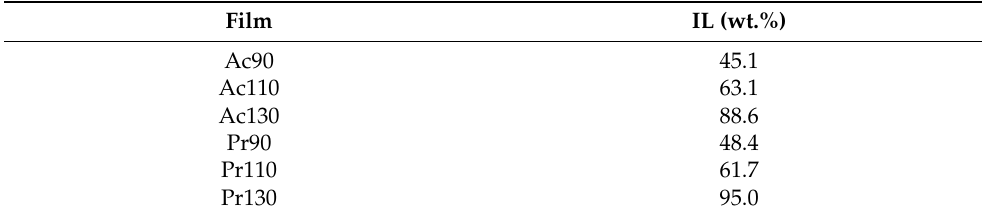
Table 2. TMG based solvent quantification.